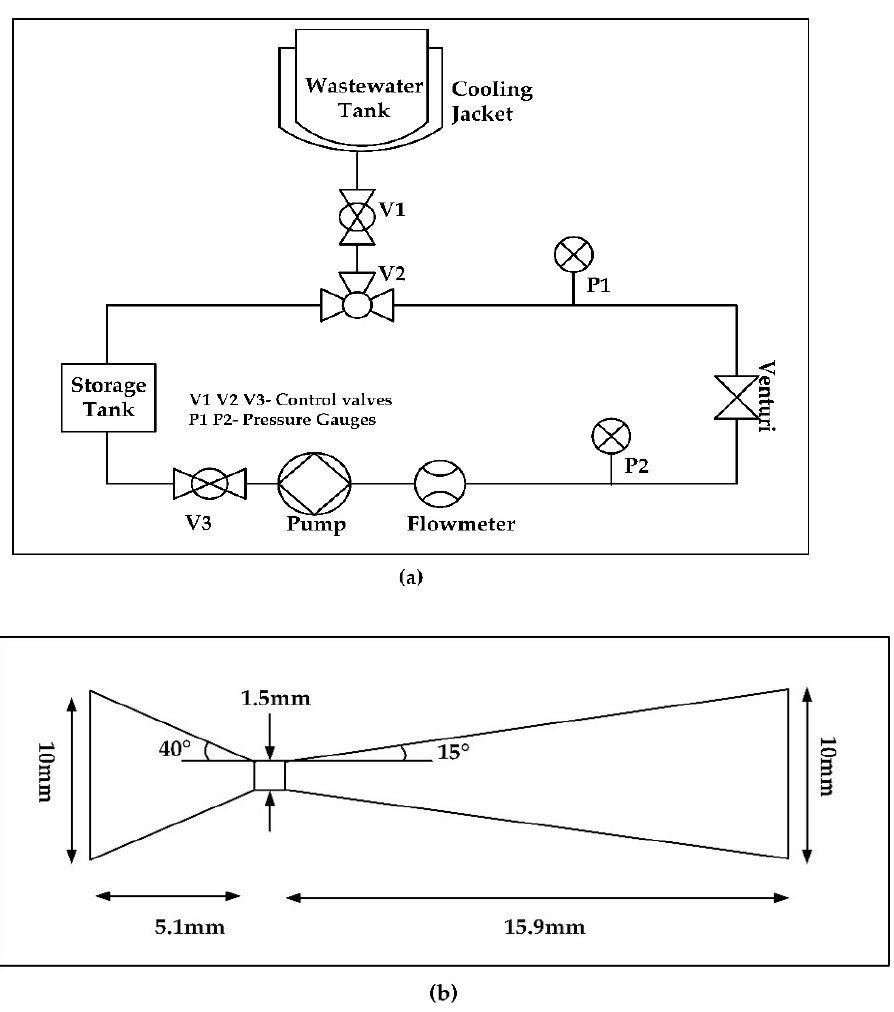
Figure 2. Schematic representation of HC set-up. ( a ) Schematic diagram of the HC system. ( b ) Geometric specifications of a Venturi used as a cavitating device.